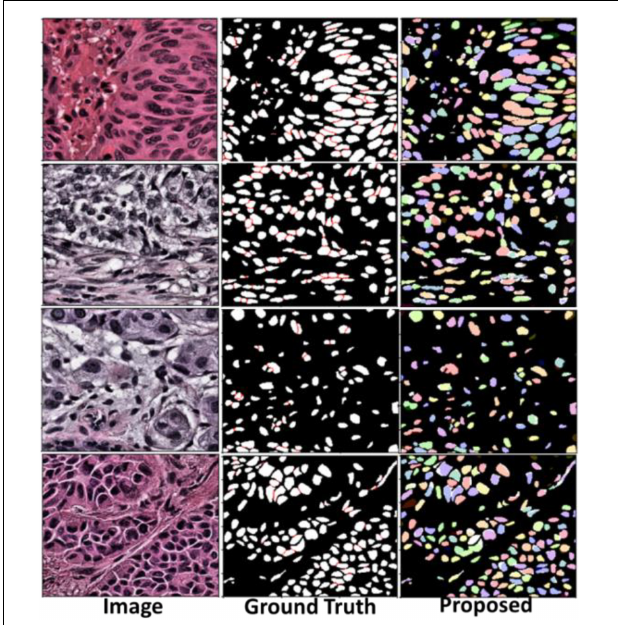
FIGURE 10 | Segmentation result in validation dataset. The left column shows tissue images. The middle column is ground truth masks. The right column shows results from the segmentation method.